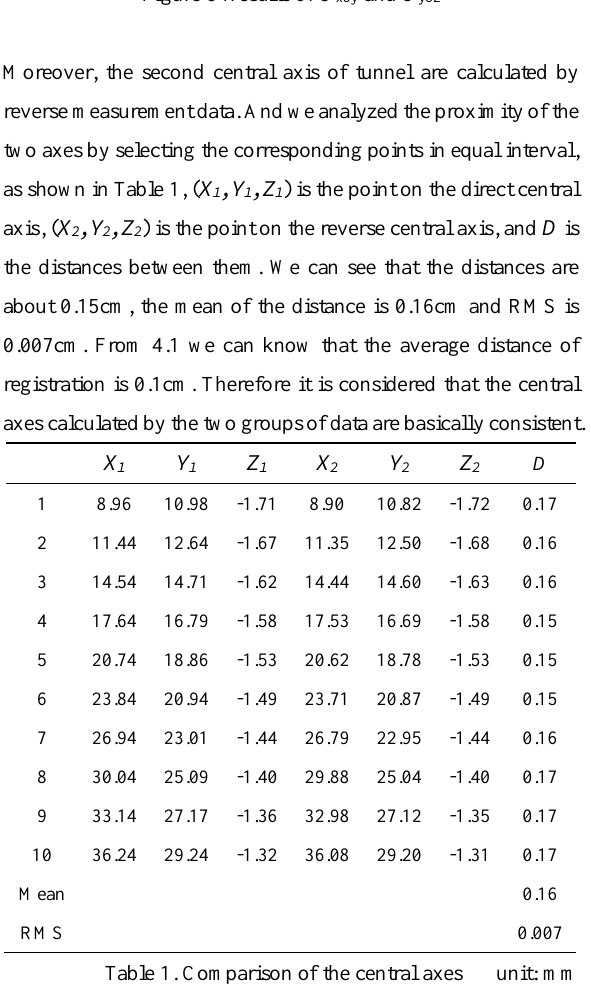
4.2.2 Result of cross sections: Based on the central axis,